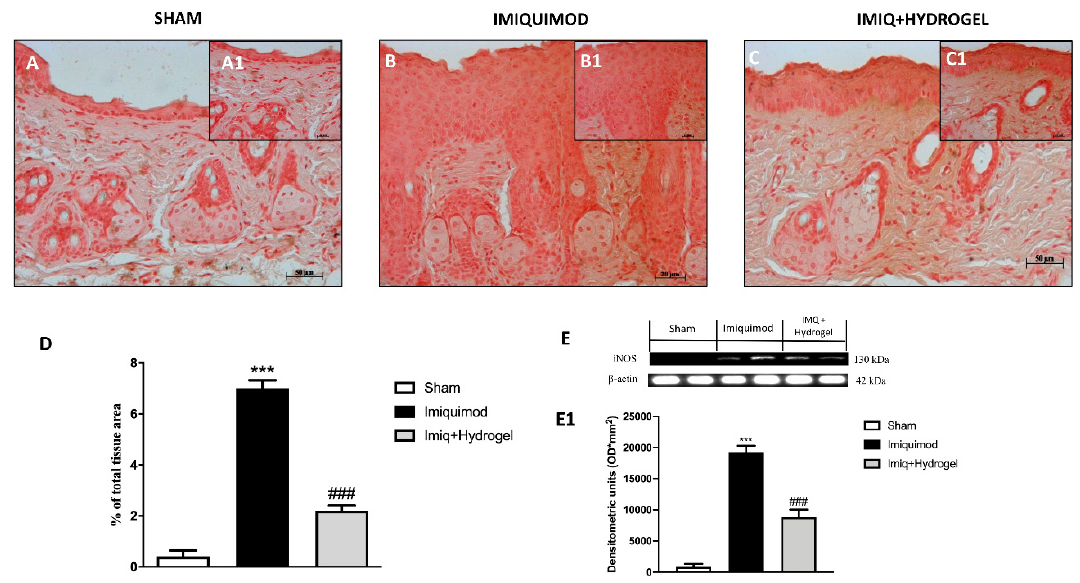
Figure 8. Effect of Hydrogel treatment on iNOS levels. By immunohistochemical analysis, it turned out that the level of iNOS was increased in mice of vehicle groups that received IMQ treatment ( B magnification 20 × , B1 magnification 40 × , D , E , E1 ) compared to the sham-operated mice ( A magnification 20 × , A1 magnification 40 × , D , E,E1 ). Moreover, Hydrogel treatment significantly decreased iNOS levels ( C magnification 20 × , C1 magnification 40 × , D , E , E1 ). Data are representative of at least three independent experiments; One-Way ANOVA test. *** p < 0.001 vs. sham; ### p < 0.001 vs. IMQ.